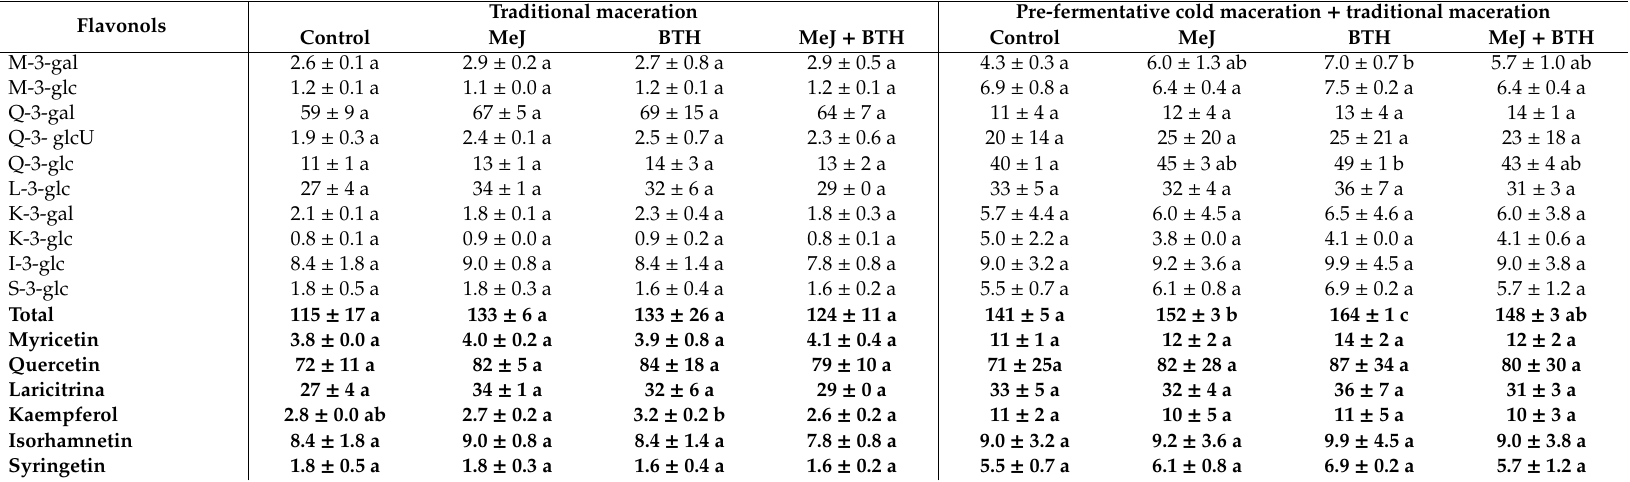
Table 6. Concentration of flavonols expressed as mg / L at the end of alcoholic fermentation in Monastrell wines ( 2016 ).